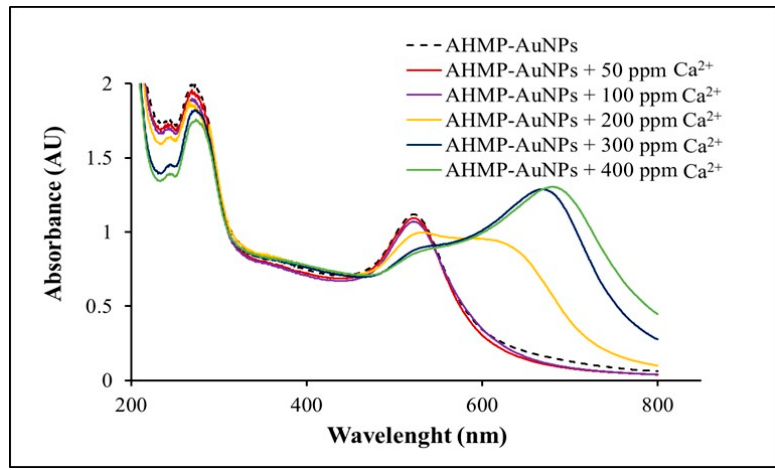
Figure 2. UV–Vis absorption spectra of AHMP-AuNPs (dot line) and AHMP-AuNPs in the presence of Ca 2 + at 50 (red line), 100 (purple line), 200 (yellow line), 300 (navy line), and 400 ppm (green